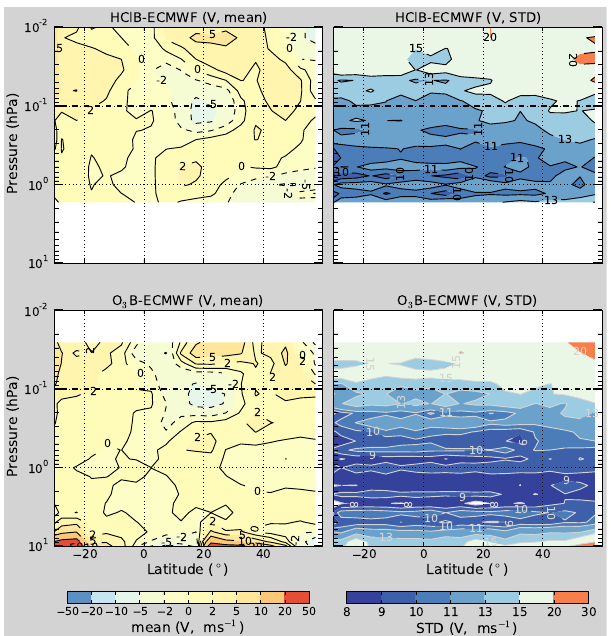
Fig. 9. Same as for Fig. 8 but for the near zonal component. Data with a line-of-sight orientation between ± 10 ◦ from the zonal direc- tion are